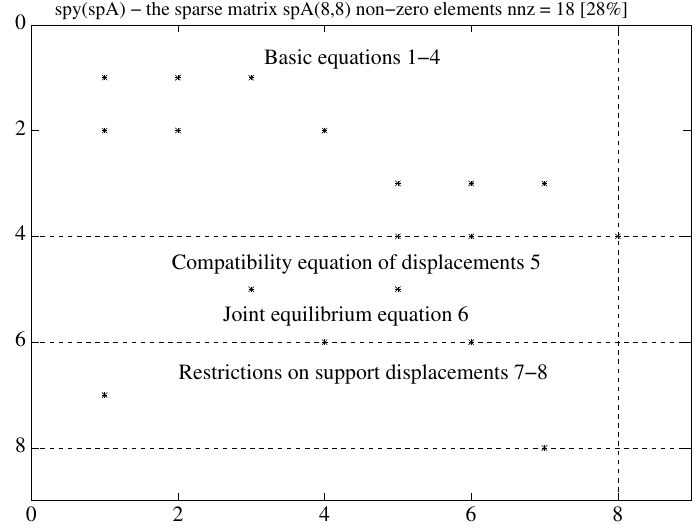
Fig. 5. Sparsity pattern of matrix spA of the system of equations for determining the amplitudes of axial displacements and forces